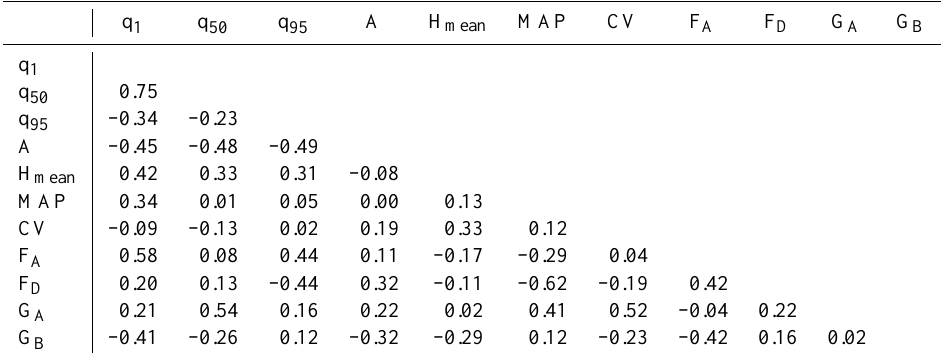
Table 3. Correlation matrix between discharge quantiles and geomorphological characteristics.